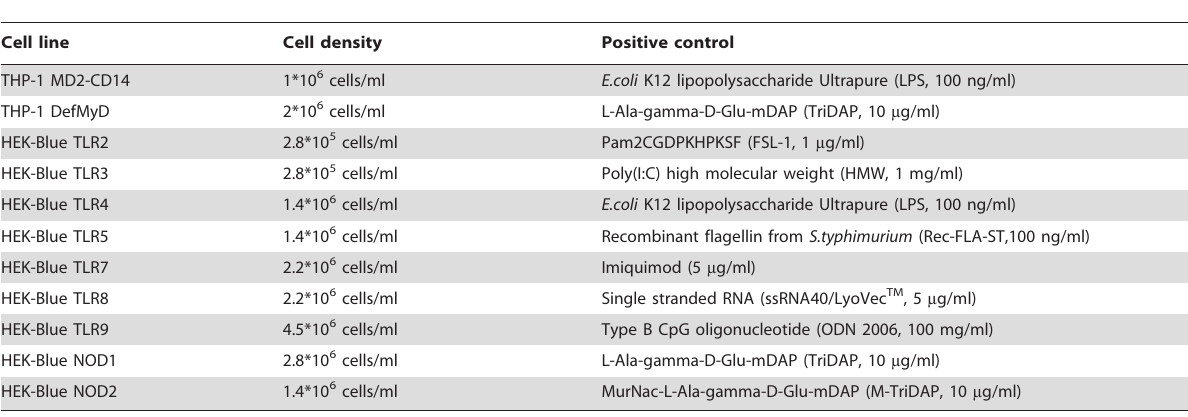
Table 1. Cell densities and positive controls used in reporter cell